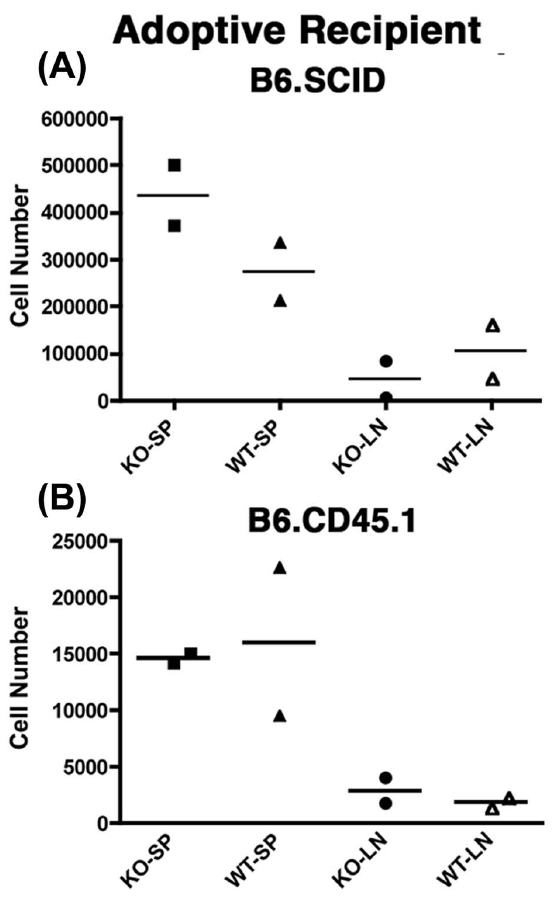
Figure 6. Nfatc2 deficiency leads to enhanced proliferation in a lymphodepleted environment of homeostatic expansion, but does not provide improved survival fitness in a competitive lymphoreplete environment. CD4 + CD25 2 Tconvs were prepared as described from WT and from Nfatc2 KO mice. Sorted cells (100,000) were adoptively transferred into the tail vein of two B6.SCID (top) or two B6.CD45.1 (bottom) mice. Recipients were sacrificed 15 days later and total cell numbers recovered from spleens (SP) and lymph nodes (LN) were enumerated using a CellDyn 3500 hematology analyzer. The percent of donor cells in each recipient was then calculated based on the percent of CD4 + CD45.2 + cells present in each preparation, and is represented by a symbol in the graphs. Lines indicate the mean for each recipient group.